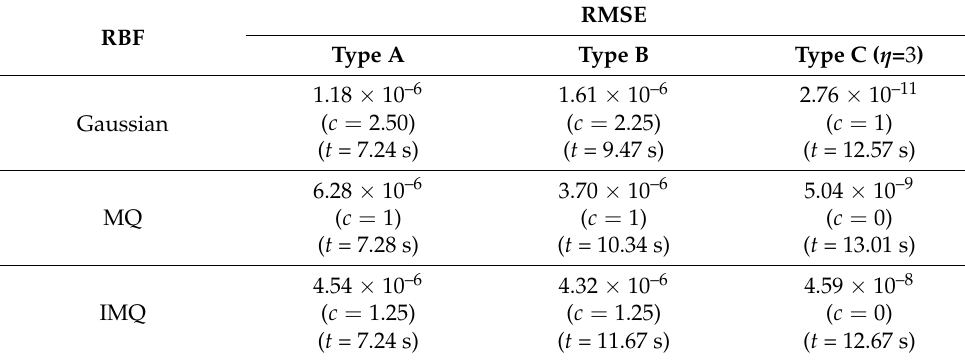
Table 4. Comparison of the results for the application example